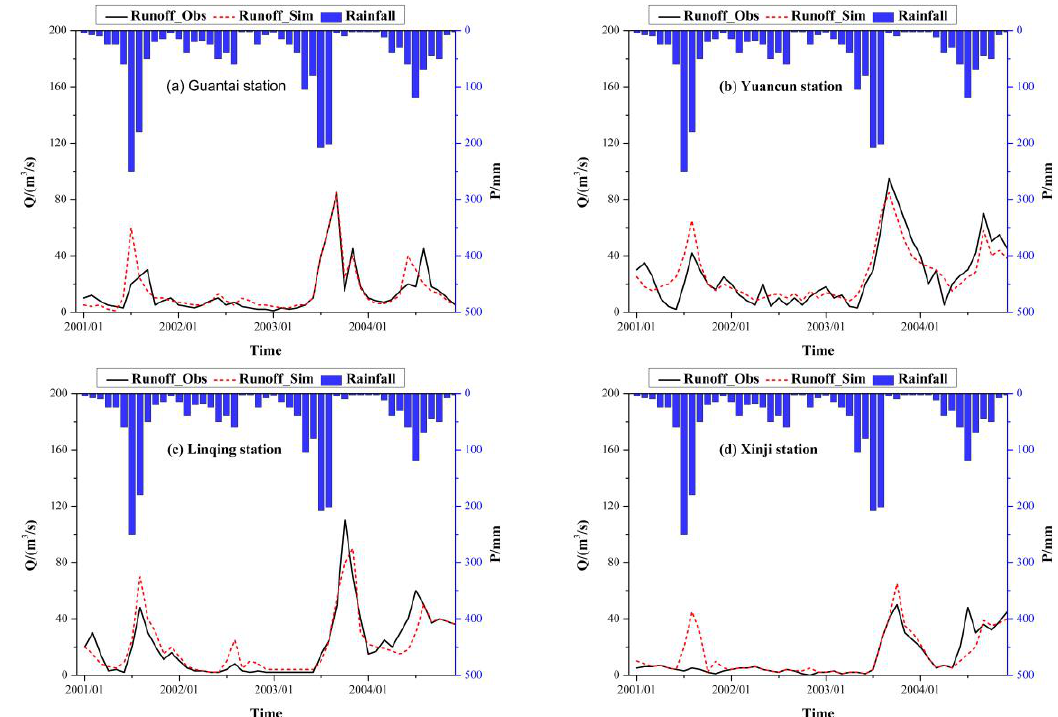
Figure 5. Comparison of observed and simulated values of monthly runoff based on the SWAT model. Table 3. Evaluation of the simulation results of monthly runoff during the calibration and validation periods at Guantai station.